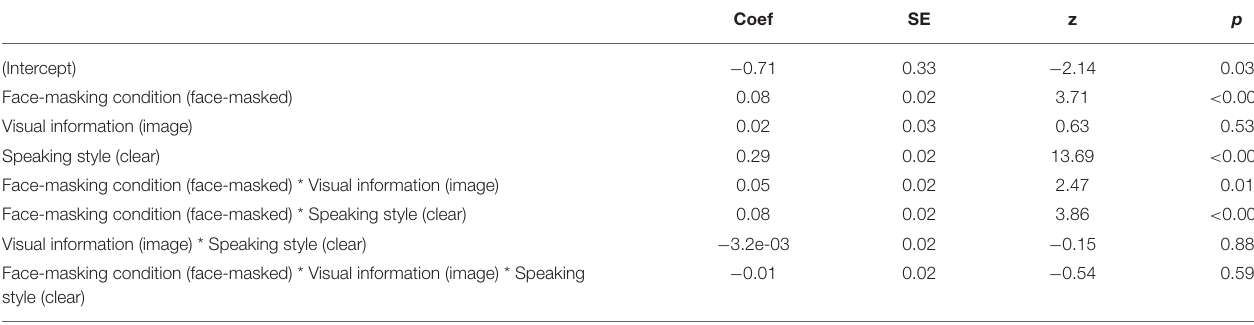
TABLE 1 | Summary statistics for the linear mixed effects model for Experiment 1, − 6 dB